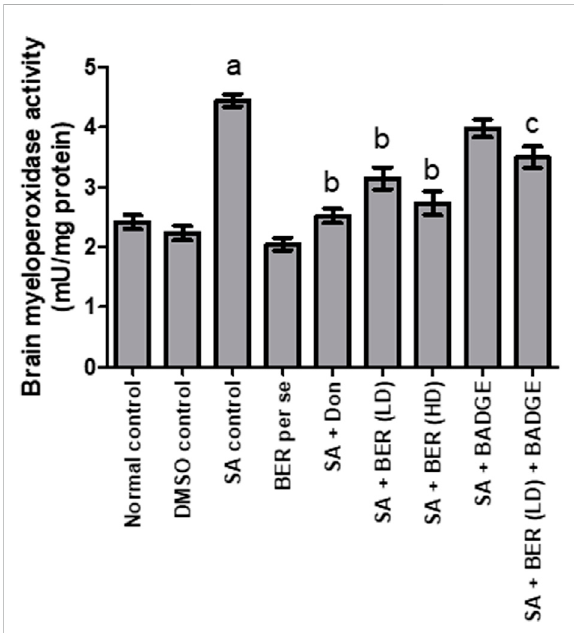
FIGURE 5 Effect of pharmacological interventions on brain TBARS level (nM/mg of protein). “ DMSO, dimethyl sulfoxide; SA, sodium azide; Don, donepezil; BER, bergenin; BER (LD), bergenin low dose; BER (HD), bergenin high dose; BADGE, Bisphenol A diglycidyl ether ” (Mehra et al., 2015). “ Each group ( n = 6) represents mean ± S.E.M, a = p ˂ 0.05 vs. normal control, b = p ˂ 0.05 vs. normal control, c = p ˂ 0.05 vs. SA control. One way ANOVA followed by Bonferroni ’ s multiple range test ” (Sodhi and Singh, 2013b).